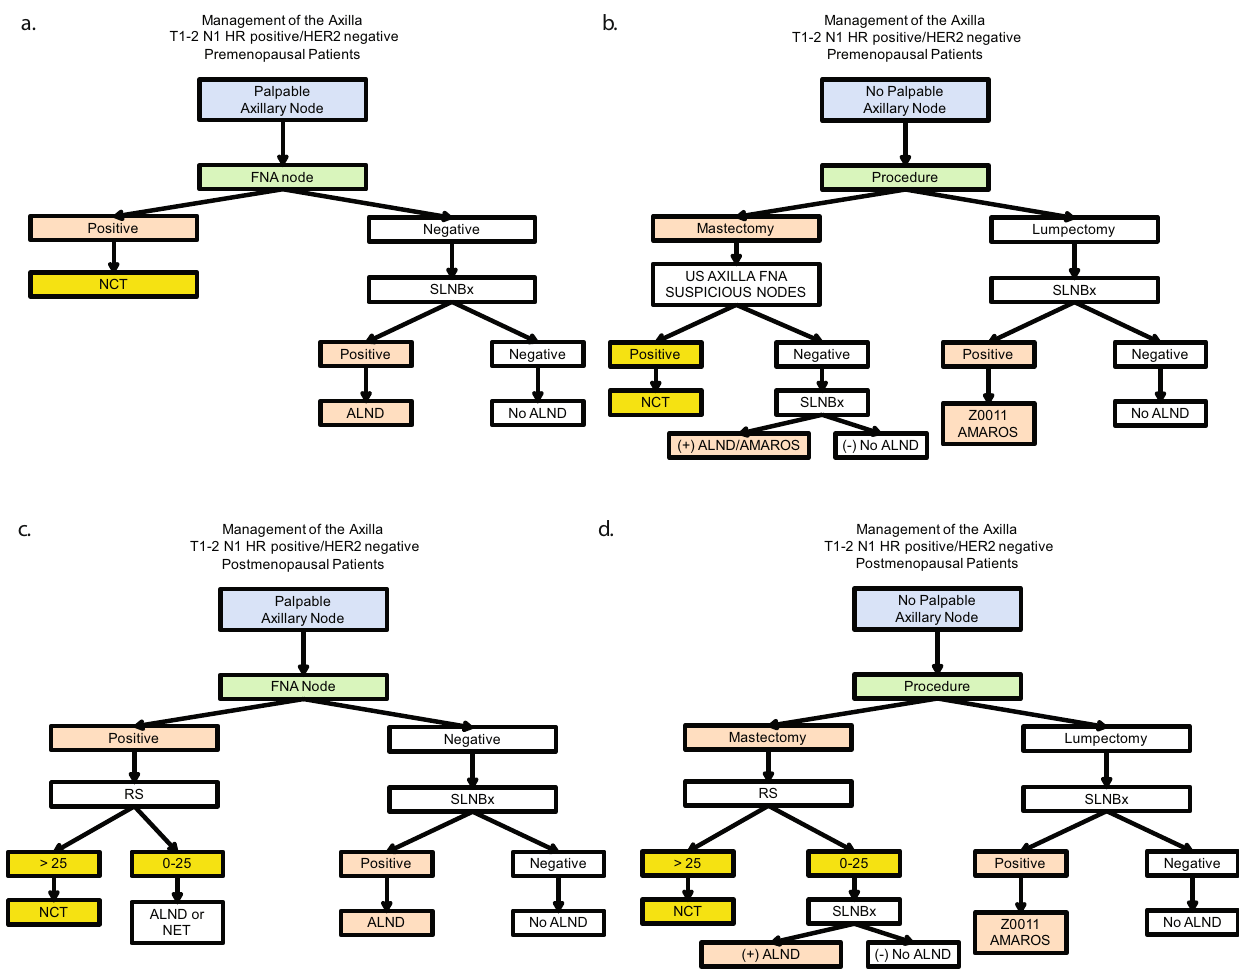
Fig. 2 Suggested management of the axilla with T1/T2 N1 disease who are hormone receptor positive/HER2 negative. a Management of the axilla for premenopausal patients with hormone receptor positive/HER2 negative T1-2 N1 patients with palpable axillary nodes. b Management of the axilla for premenopausal patients with hormone receptor positive/HER2 negative T1-2 N1 patients with no palpable axillary nodes. c Management of the axilla for postmenopausal patients with hormone receptor positive/HER2 negative T1-2 N1 patients with palpable axillary nodes. d Management of the axilla for postmenopausal patients with hormone receptor positive/HER2 negative T1-2 N1 patients with no palpable axillary nodes. TNBC triple negative breast cancer, HER2 human epidermal growth factor receptor 2, CTx chemotherapy, SLNB sentinel lymph node biopsy, XRT radiation therapy, ALND axillary lymph node dissection, HR hormone receptor, FNA fi ne-needle aspiration, NCT neoadjuvant chemotherapy, RS Oncotype DX recurrence